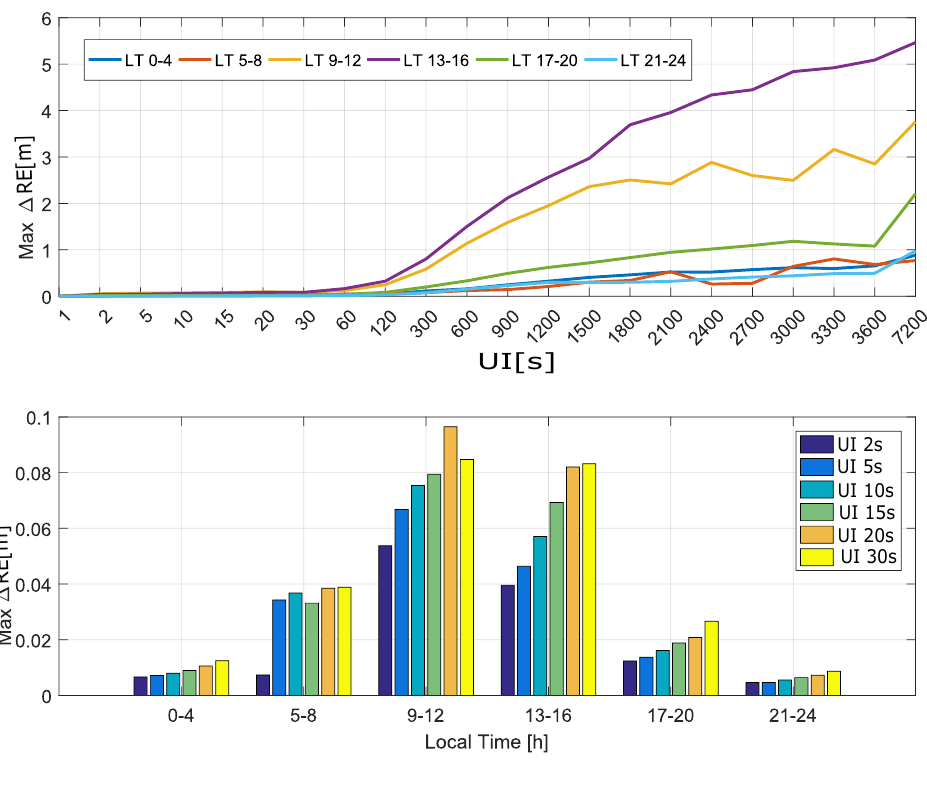
Figure 10. Maximum absolute RE differences as a function of the local time. In the legend, “UI” stands for “Update